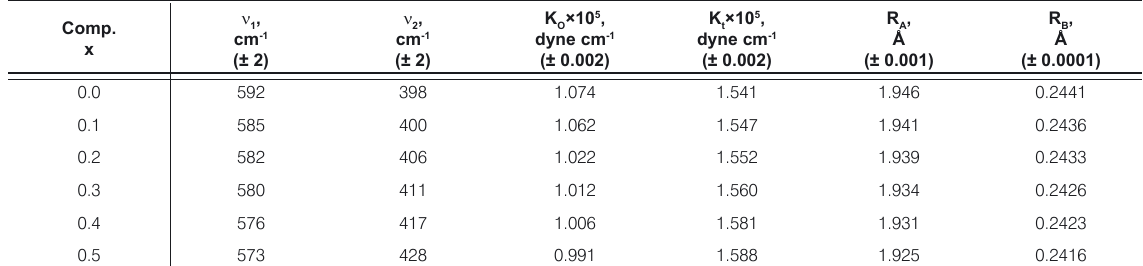
and n ), force constant (K 1 2